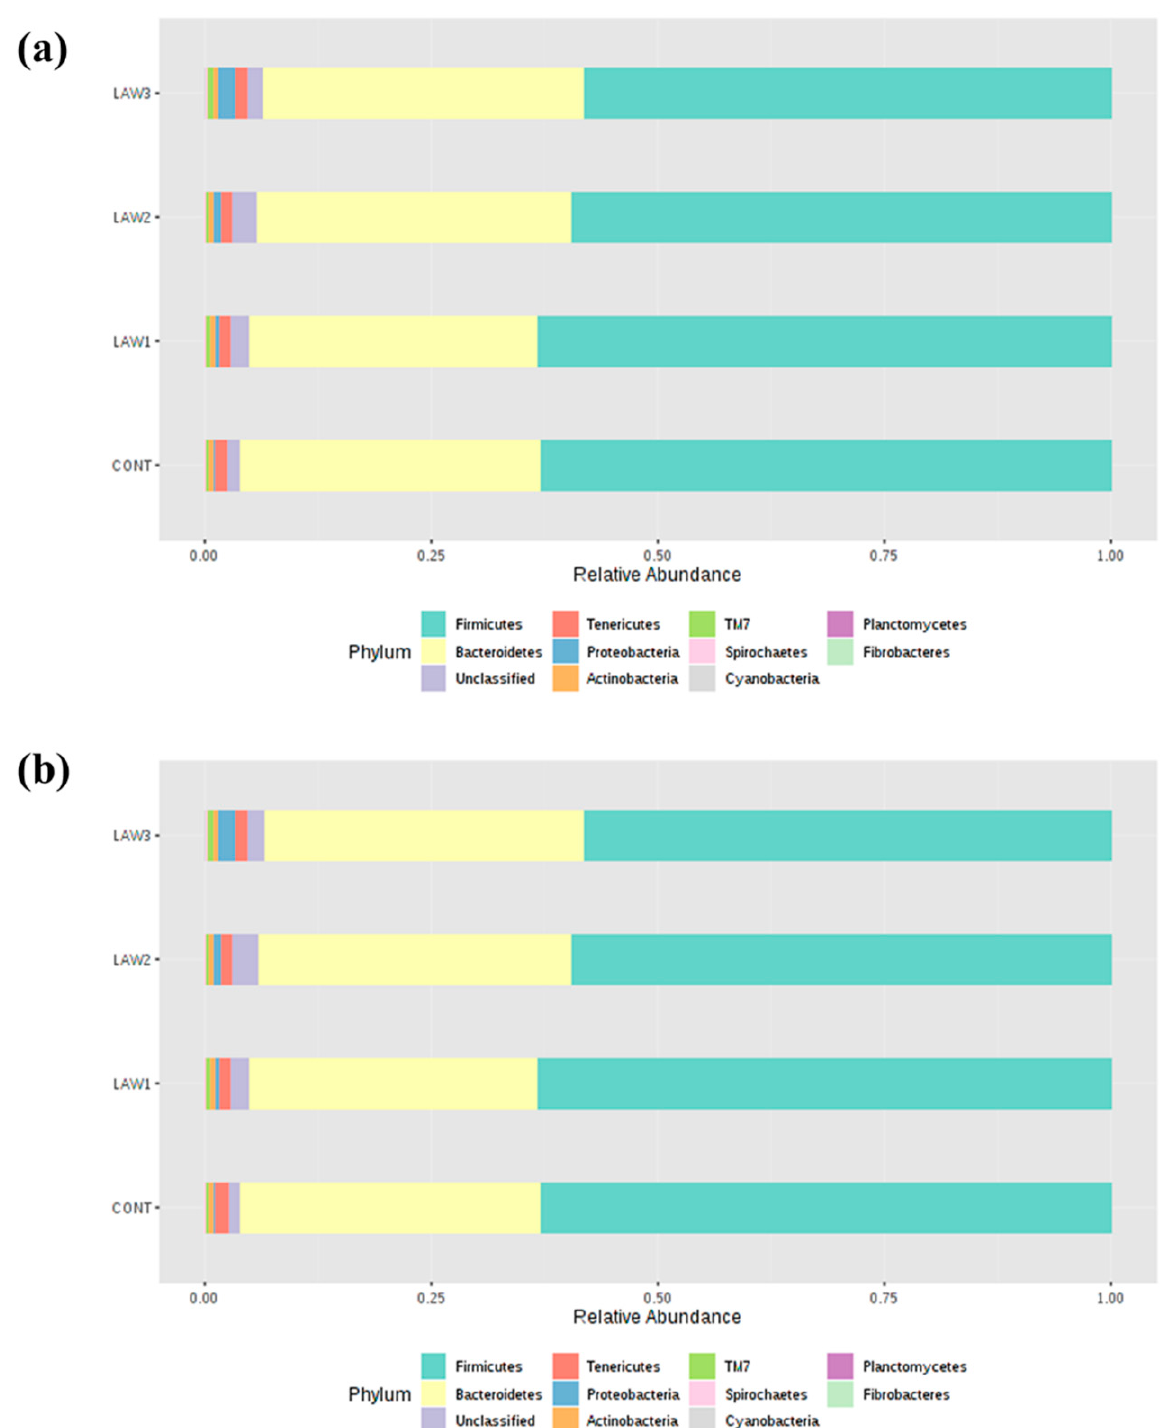
Figure 3. Gut microbiota composition at the phylum level in pigs orally vaccinated with Lawsonia intracellularis vaccine. Bar plots show the relative abundance of taxa at the phylum level at ( a ) week 0 and at ( b ) week 6 among the four treatment groups (CONT, LAW1, LAW2 and LAW3).